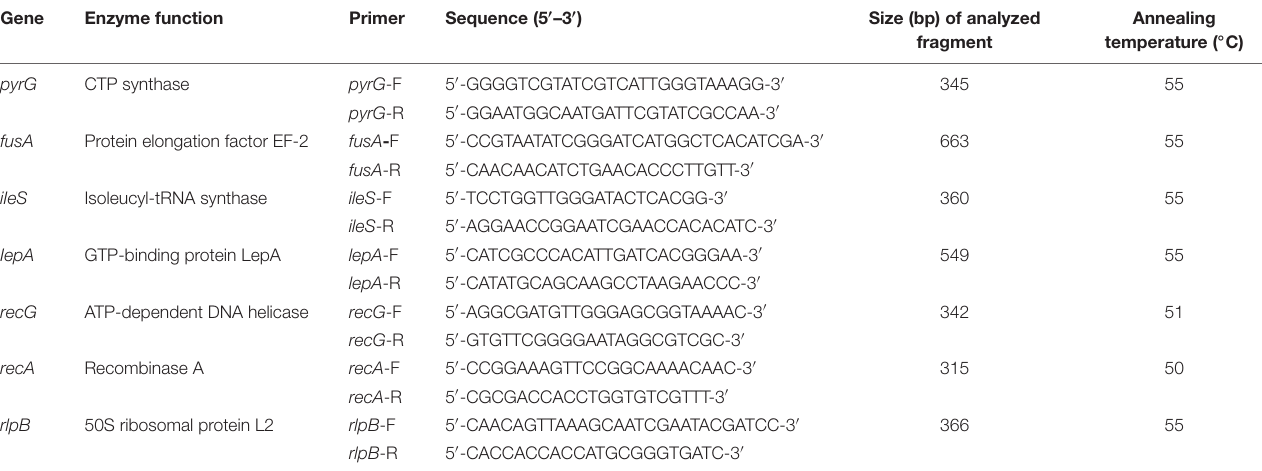
TABLE 1 | Housekeeping genes and primer information for MLST of L.